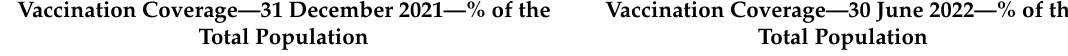
Table 2. COVID-19 vaccination coverage across African countries as of 31 December 2021 and 30 June 2022.